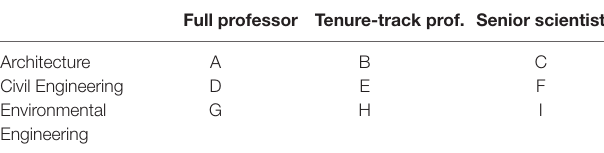
Table 1 | Affinity Map evaluation has been conducted through